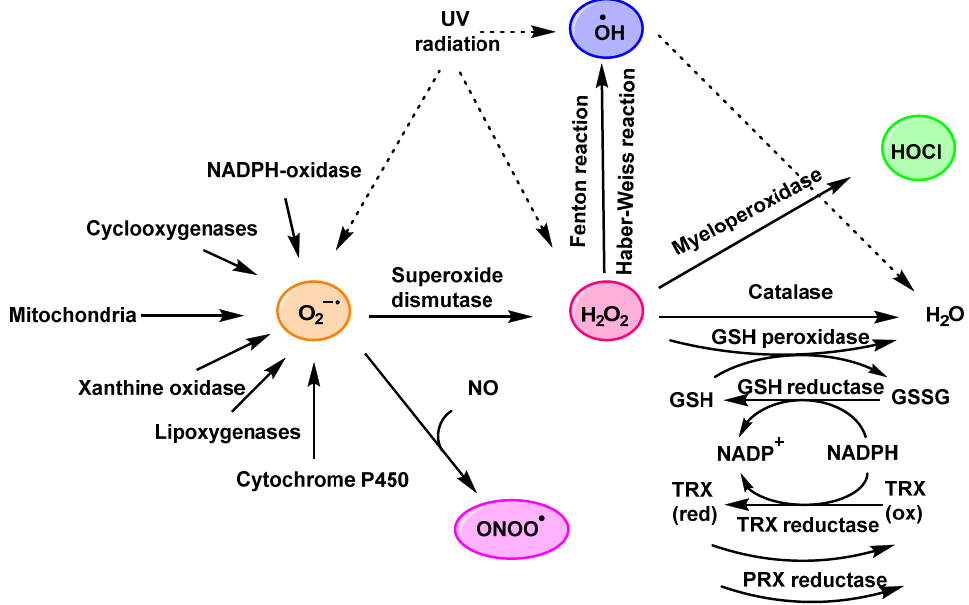
Figure 1. Chemical and enzymatic reactions generating ROS and main antioxidant